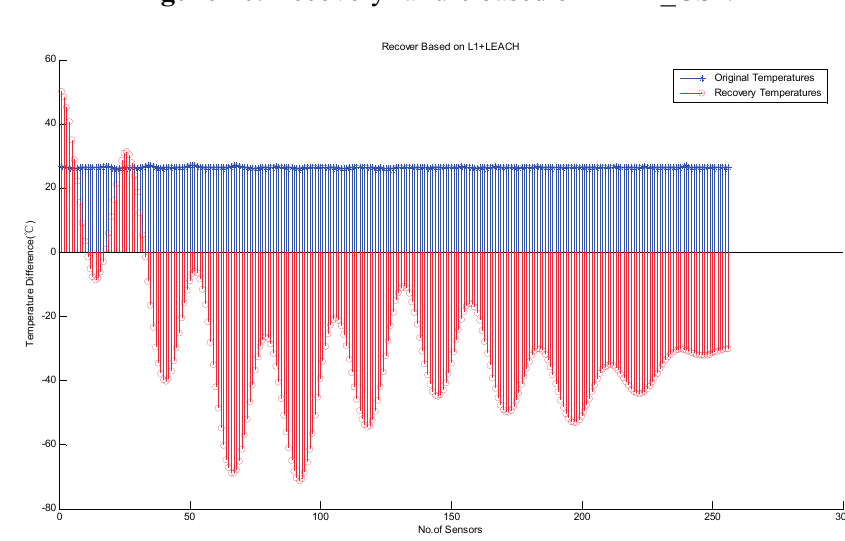
Figure 10. Recovery failure based on HRM_CS2